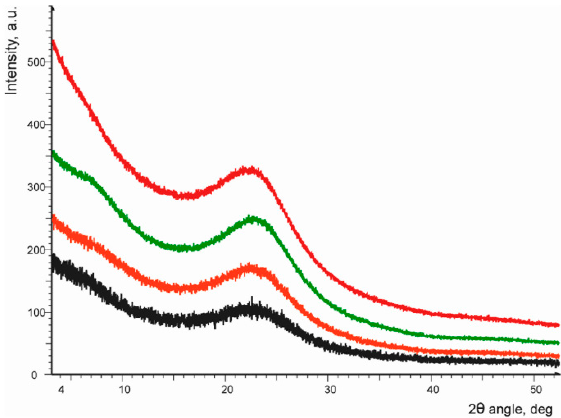
Figure 6. PXRD patterns: black—w/o SiO 2 , orange—Stöber SiO 2 , red—w/o Co II @SiO 2 , green—Stöber Co II @SiO 2 . The curves are shifted relative to each other along the intensity axis for clarity.